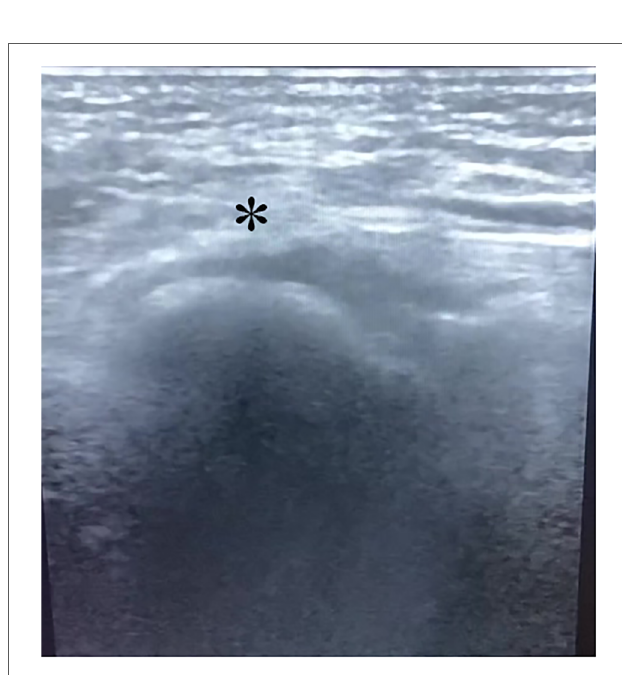
FIGURE 4 The asterisk indicated the presence of FHL tendon in the malleolar canal by the dynamic